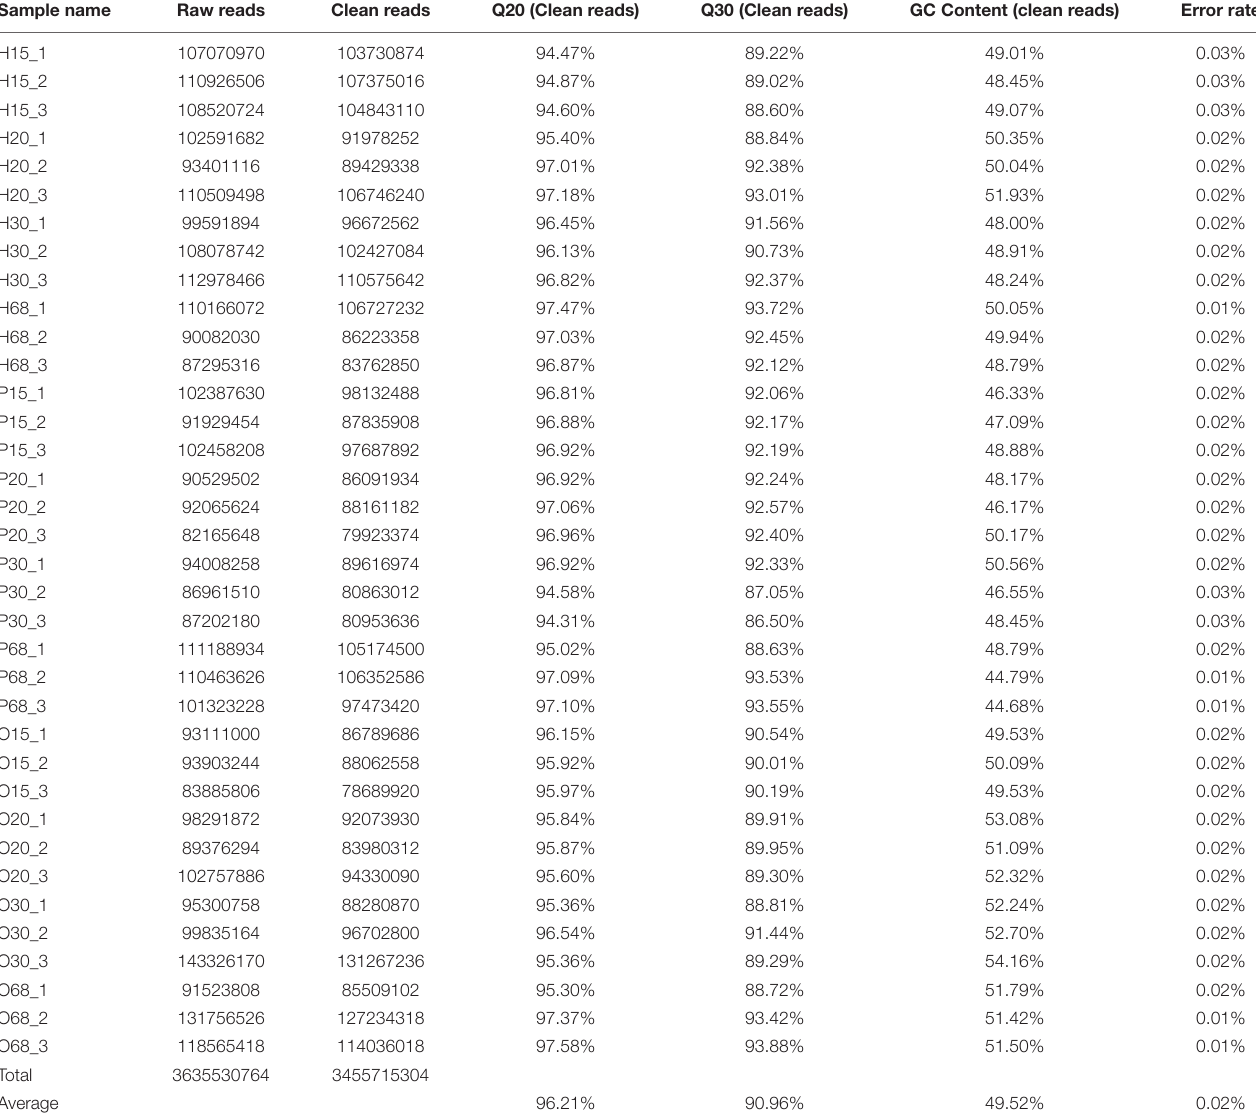
TABLE 1 | Raw data, clean data, quality and GC content of 36 transcriptomes from the tissues of hypothalamus-pituitary-ovarian (HPO) axis at four ages of